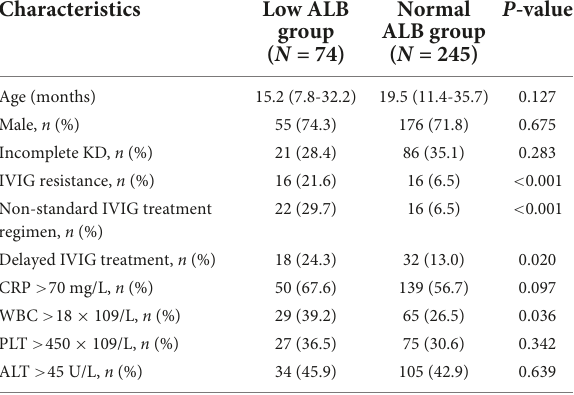
TABLE 1 Basic characteristics of Kawasaki disease patients by ALB levels. Characteristics